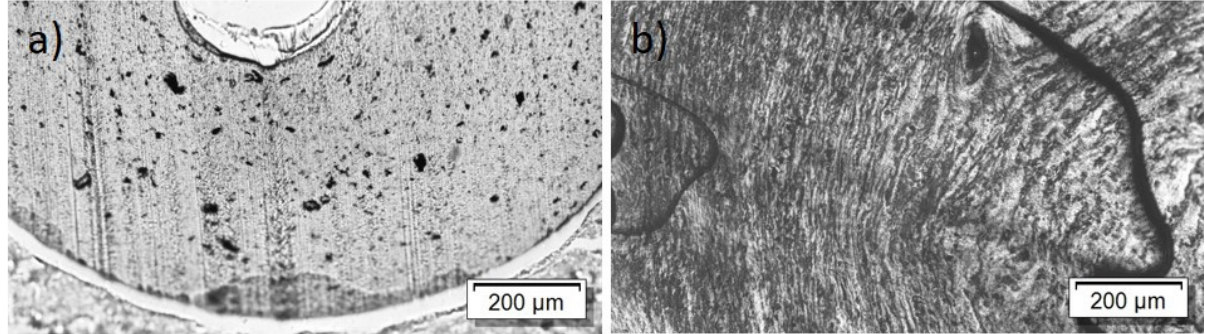
Figure 8. Transmission light microscopy images of PEEK/1 wt% Tuball TM with different amounts of PEG: ( a ) without PEG, 2 wt% PEG ( b ).